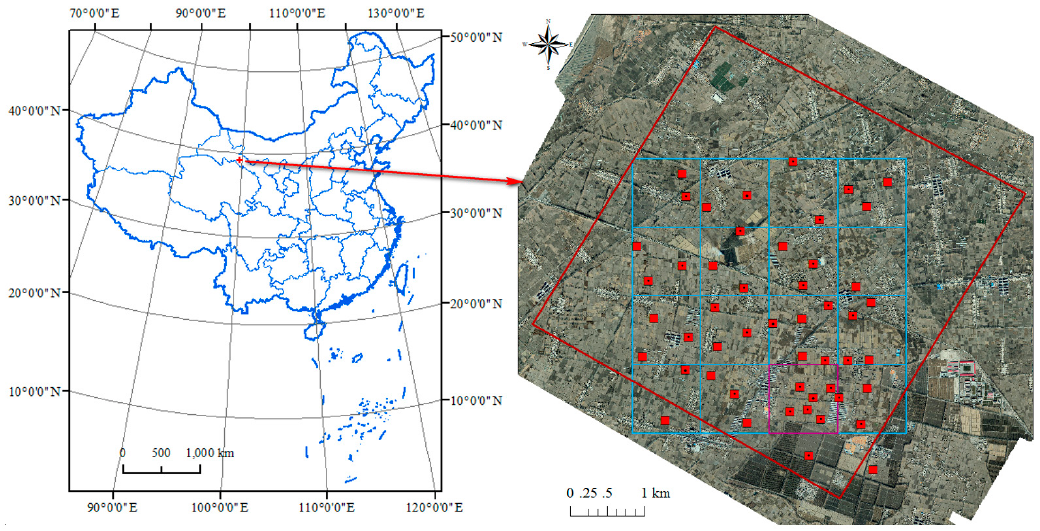
Figure 1. Location of study area and the distribution of wireless sensor network nodes.